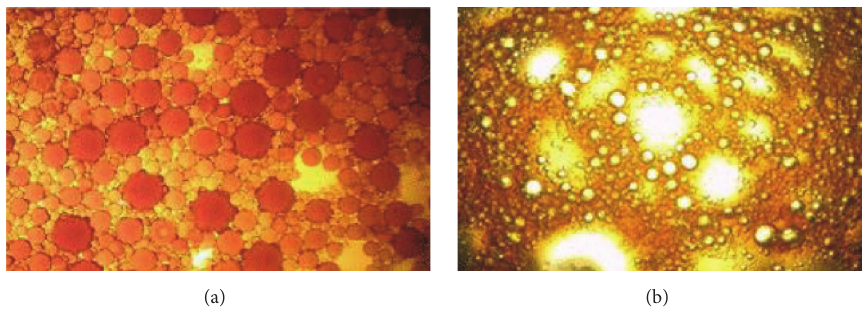
Figure 7: Microscopic views of the (a) water-external emulsion and (b) oil-external emulsion,